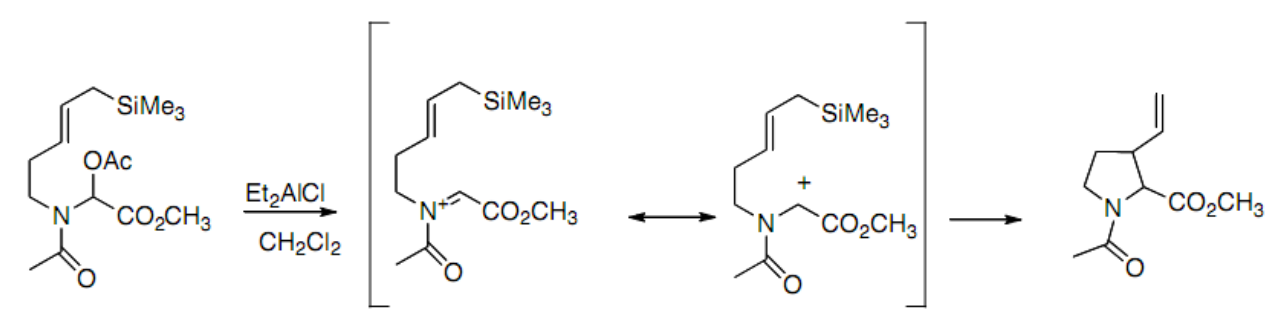
Scheme 11. Intramolecular cyclization of N -acyliminium